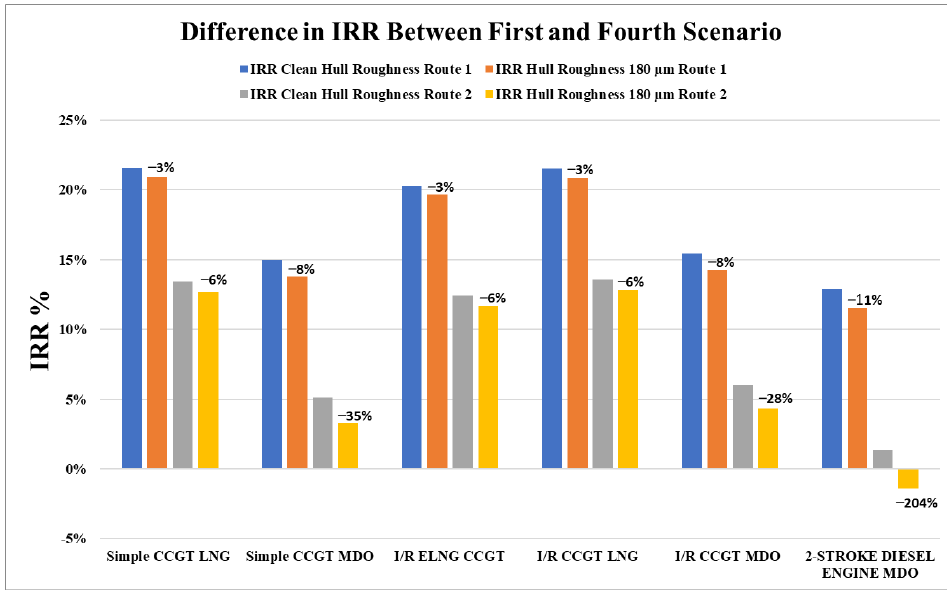
Figure 12. Difference in IRR between the first and fourth scenarios for Routes 1 and 2.